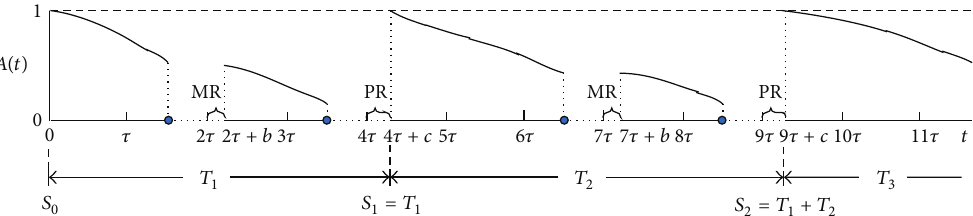
Figure 1: The structure sketch of a periodically inspected system maintained through several minimal repairs before a replacement or a perfect repair, where “ ∙ ” denotes the system failure, MR and PR denote minimal repair and perfect repair or replacement, respectively, and 𝑚 is prefixed as